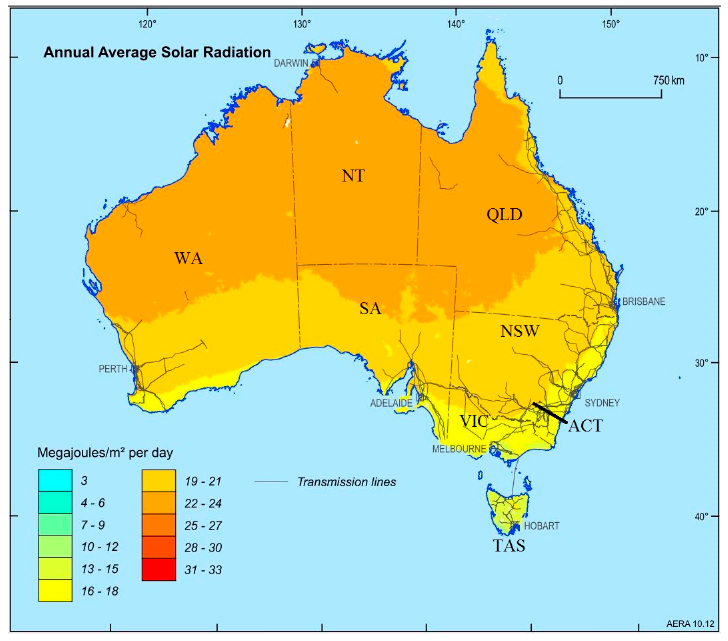
Figure 1. Annual average solar radiation in Australia [7].